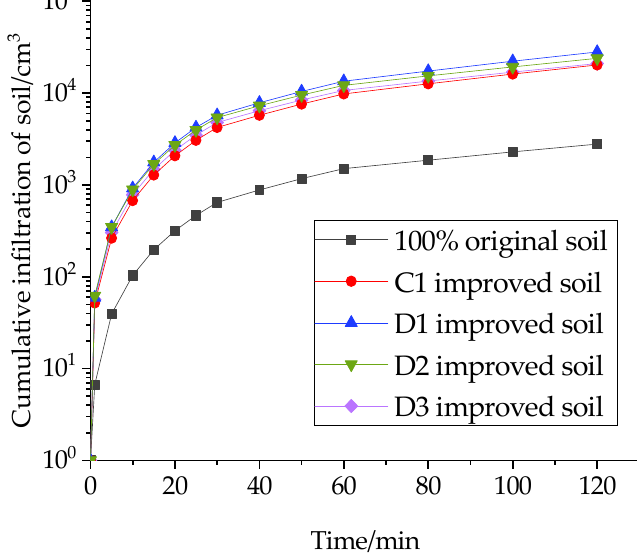
Figure 5. Effect of structural ameliorants on cumulative soil infiltration.